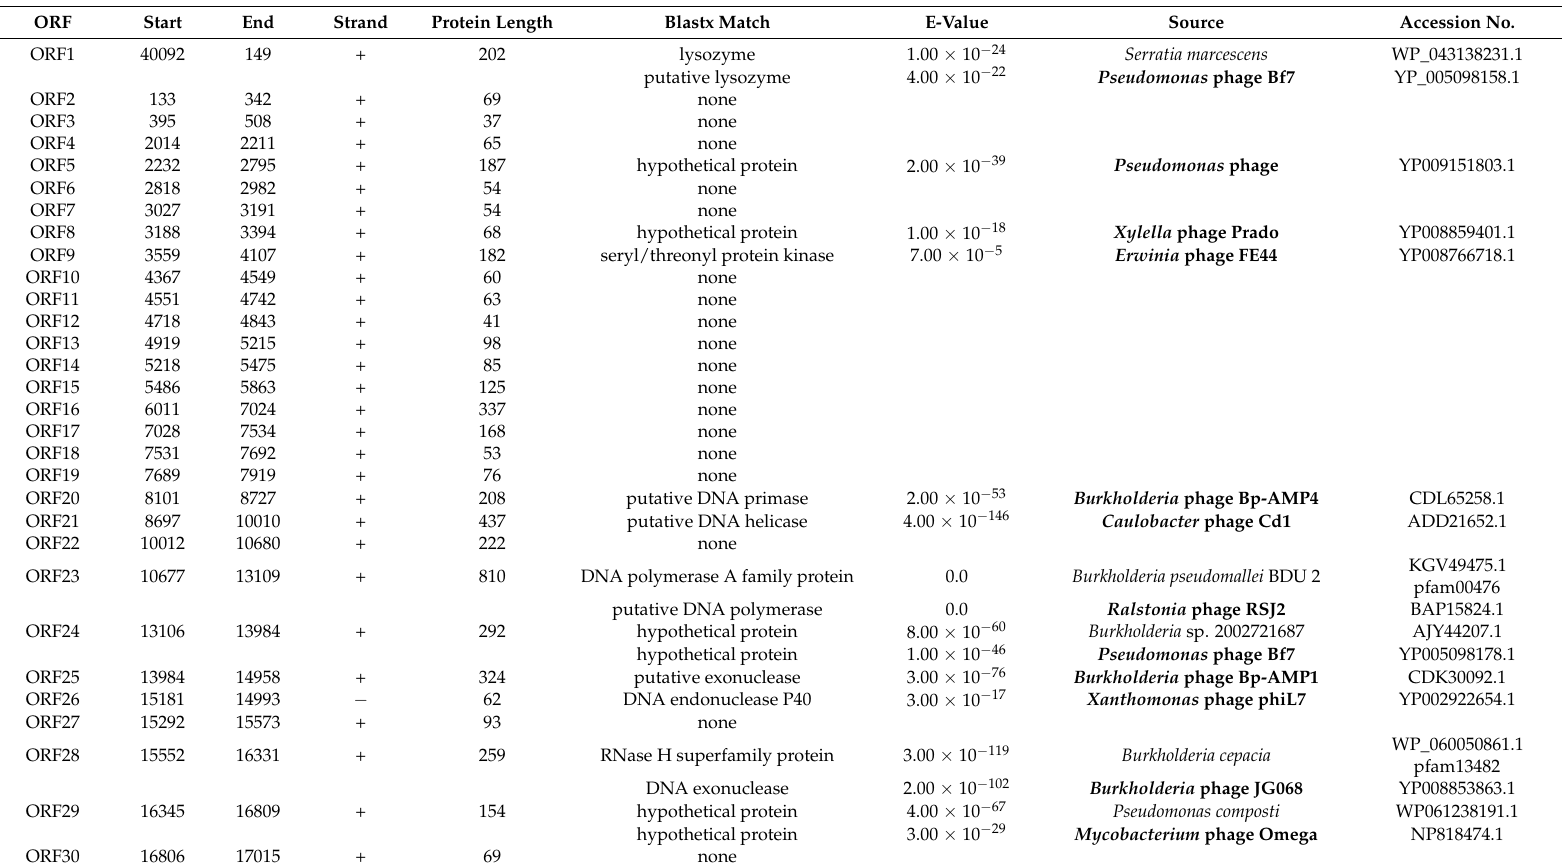
Table 1. Open reading frames on the genome of the Aquamicrobium phage P14 and their blastx [29] hits. Sources of similar proteins that are phages are marked in bold. Only blastx matches with an E-value smaller than 0.00001 are